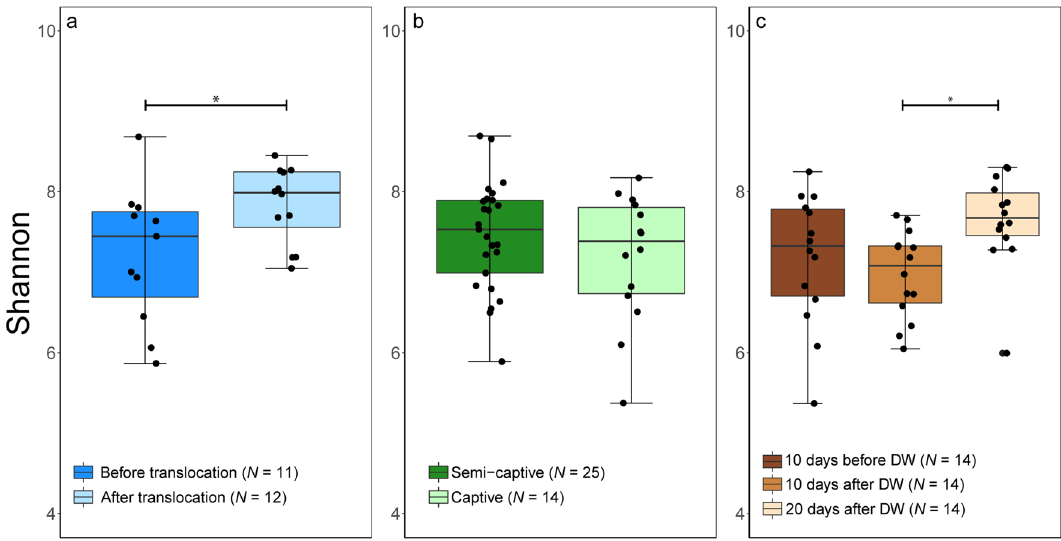
Figure 2. Box and whisker plot describing the alpha diversity comparisons between microbiome communities in Asian elephants. Shannon index was used to quantify the microbiome diversity in elephants before (BT) and after (AT) translocation (a) , in captivity and semi-captivity (b) and 10 days before, 10 days after and 20 days after deworming (c) . * p < 0.05 (Wilcoxon-signed rank test).